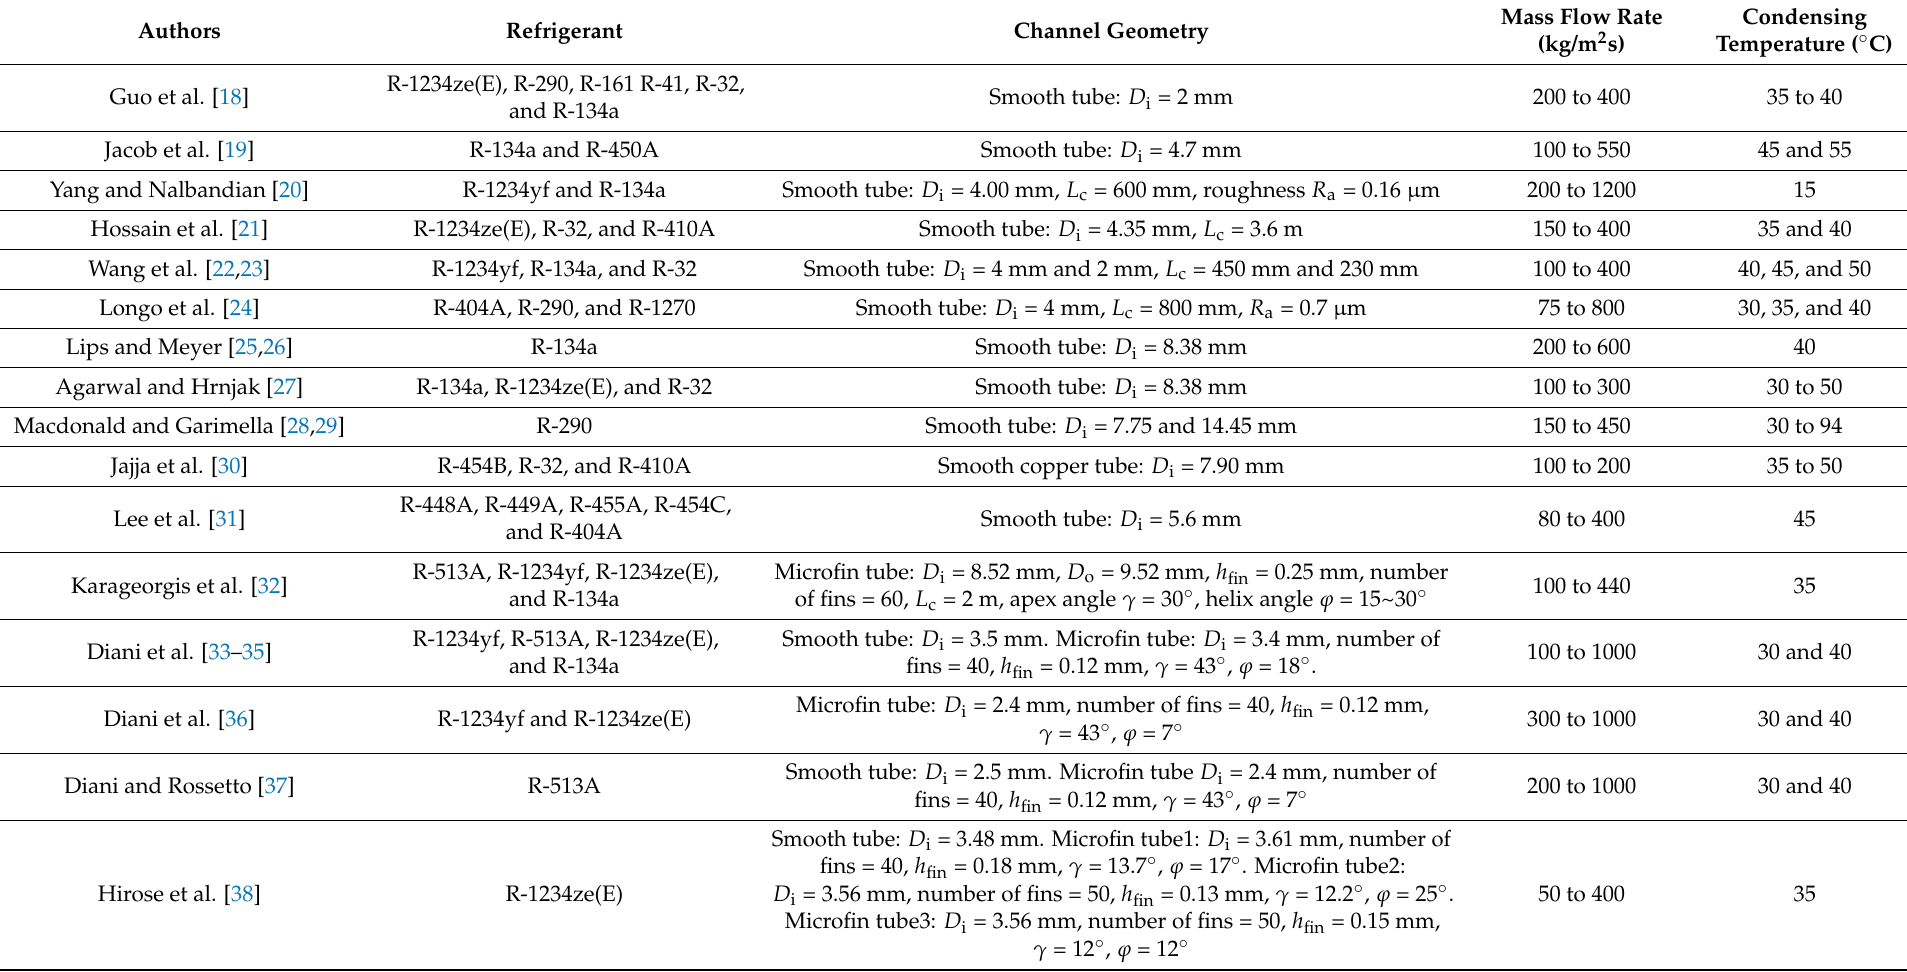
Table 3. Dimensions/specifications of minichannel/microfin tube and experimental conditions reported in the